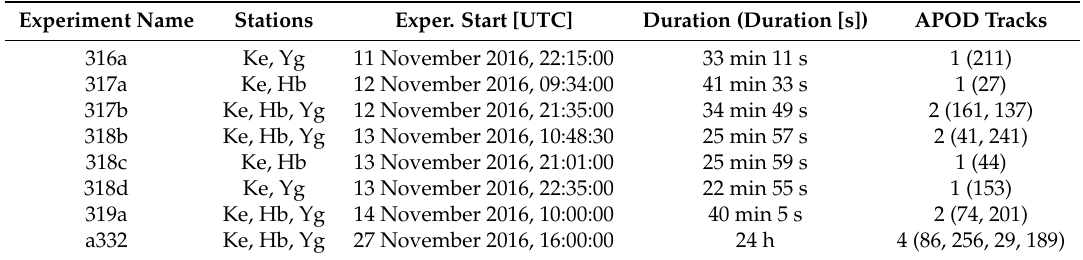
Table 1. A list of APOD experiments by AuScope in November 2016. Experiments 316a to 319a lasted for about 40 min at most observing one or two consecutive single-baseline scans to APOD shortly after another. Experiment a332 lasted for 24 h mostly observing quasars in a geodetic schedule plus four APOD tracks in between. The last column (APOD tracks) indicates the number of APOD tracks observed in this session and the duration of each scan in seconds (in